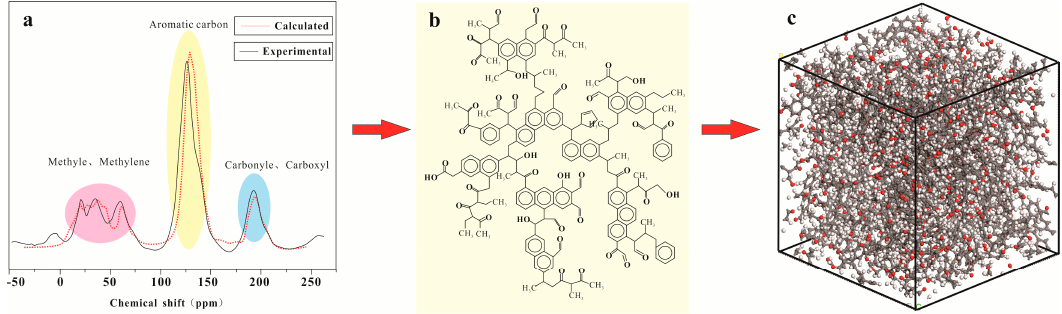
Figure 1. Two-dimensional to three-dimensional TL-1 structural models. ( a ) experimental and calculated 13 C NMR spectrum ( b ) two-dimensional structure ( c ) three-dimensional structure.